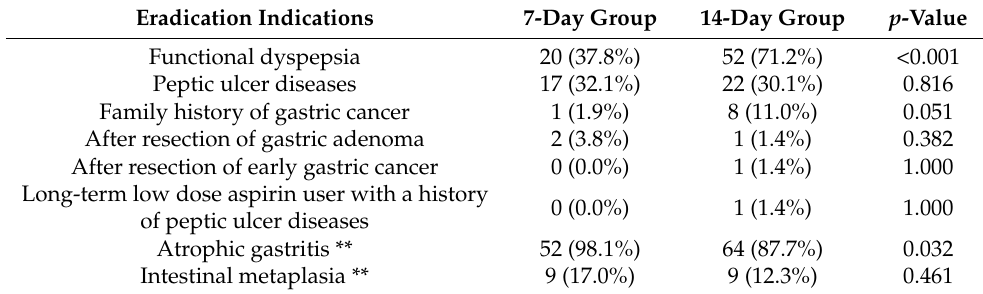
Table 2. Comparisons of the two study groups by eradication indications